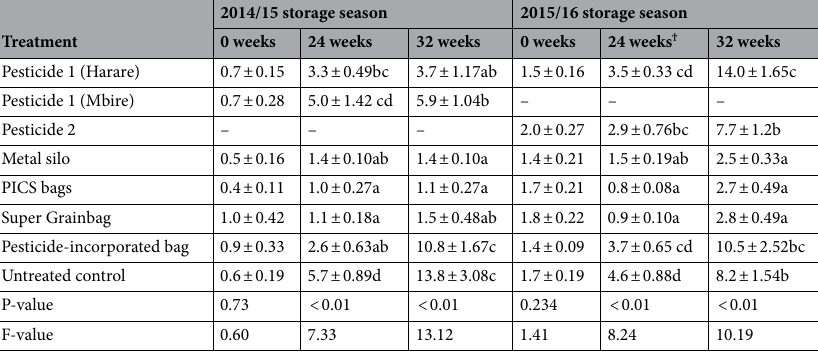
Table 4. Mean percentage sorghum grain weight losses at selected critical points during the two storage seasons in Mbire district, Zimbabwe (n = 8). Ϯ Mean separation letters in this column were derived from square root transformed data; ‘–’ indicates absence of treatment in the ward (s); Means were compared per column, and those which do not share the same letter are significantly different from one another using Tukey’s test at 0.05 level. Pesticide 1 = fenitrothion 1% + deltamethrin 0.13%; Pesticide 2 = pirimiphos-methyl 0.16% + thiamethoxam 0.036%; Pesticide-incorporated bag = deltamethrin-incorporated polypropylene bag at